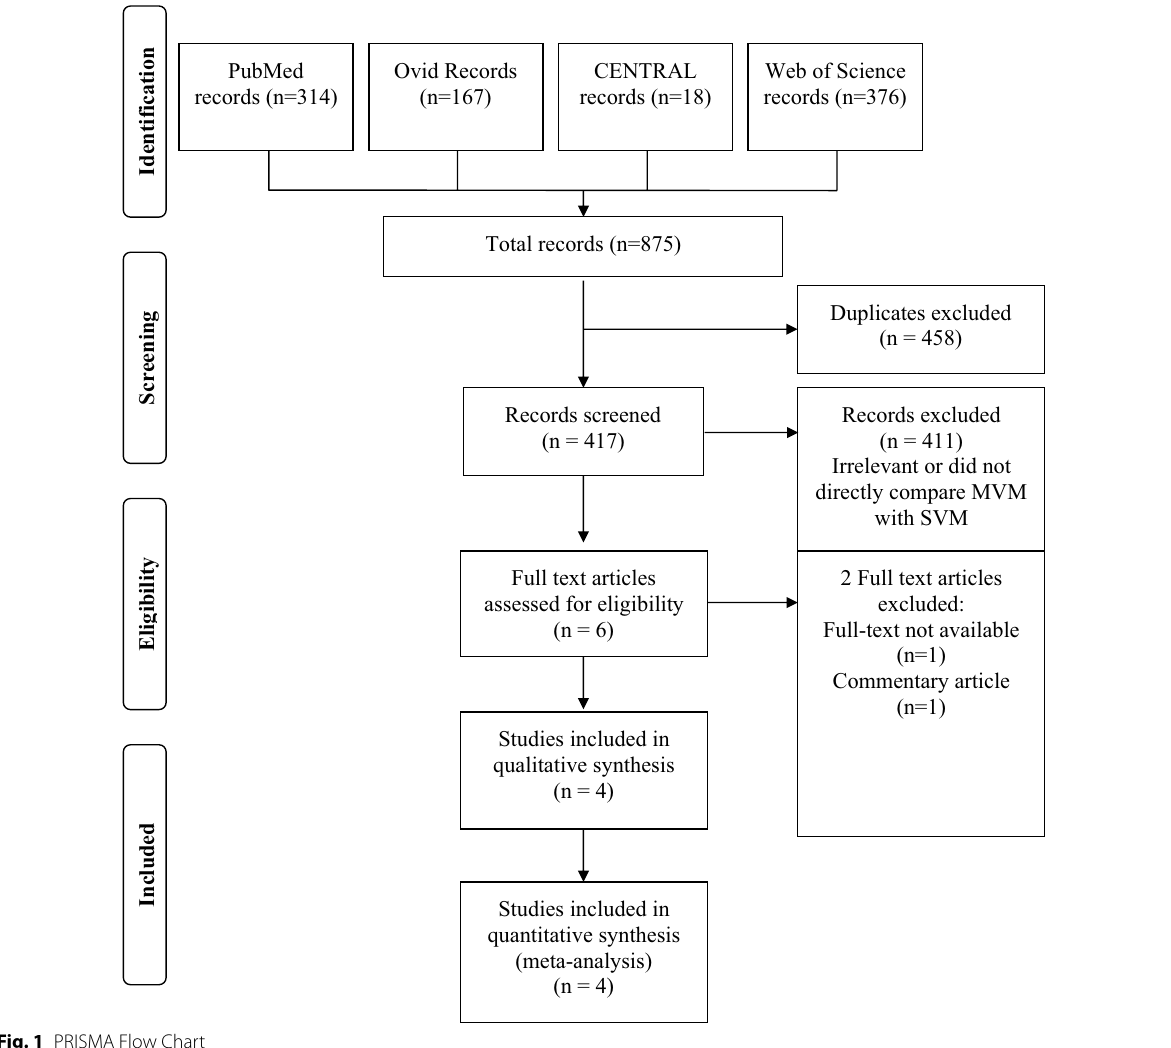
Fig. 1 PRISMA Flow Chart